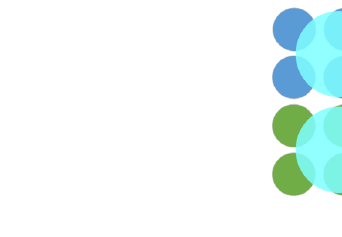
Figure 8. Schematic diagram of imaging spot distribution under different link misalignments. ( a ) The degree of link misalignment is small. ( b ) The degree of link misalignment is large. Figure 9 shows the BER curves of systems with different diversity orders in a weak turbulent environment. As shown in Figure 9, when the BER of 4 × 4 STBC encoding STBC is 2 × 2,the SNR of the 4 × 4 STBC encoding system is improved by about 5 dB compared with the 2 × 2 STBC encoding system. The higher the diversity order, the higher the system’s resistance to fading caused by turbulence.